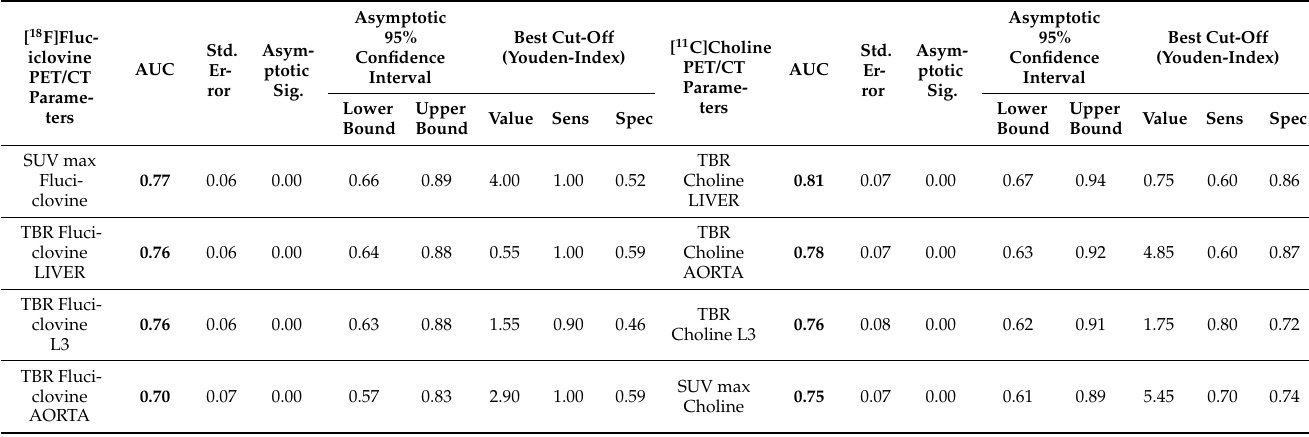
Figure 3. Receiver operating characteristics (ROC) curves of [ 18 F]Fluciclovine ( A ) vs. [ 11 C]Choline PET/CT ( B ) performance for high-grade malignant lesions (pISUP 4–5) detection, using semi-quantitative parameters (lesion-based, n = 10/95). Table 6. Comparison of [ 18 F]Fluciclovine vs. [ 11 C]Choline PET/CT performance for high-grade malignant lesions (pISUP 4–5) detection, using semi-quantitative parameters (lesion based, n = 10/95). Areas under the ROC curves (AUCs) are listed (in bold) in descending order. Best cut-off values for each parameter and corresponding sensitivity (sens) and specificity (spec) are also